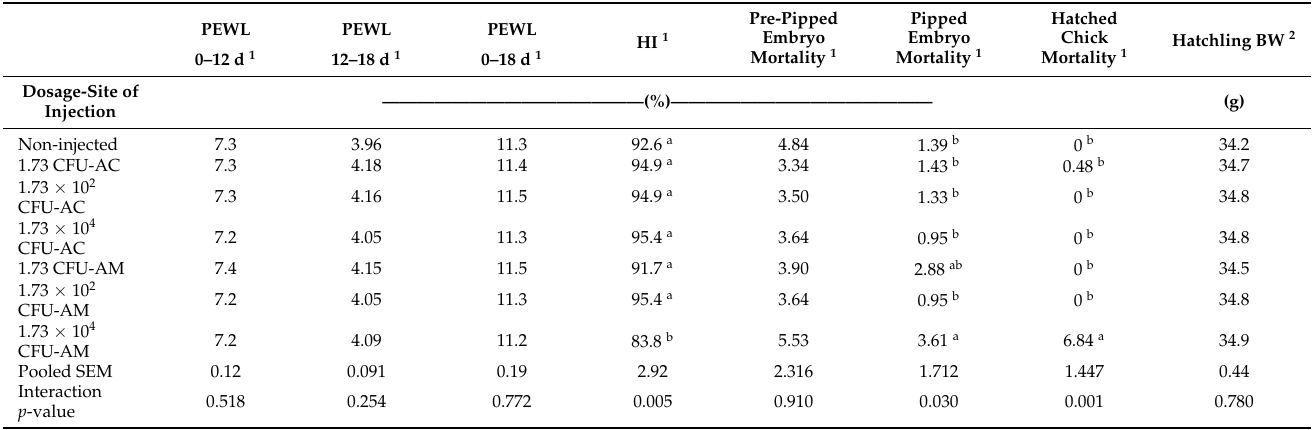
Table 4. Percentage egg weight loss ( PEWL ) between 0 and 12, 12 and 18, and 0 and 18 days ( d ) of incubation ( doi ) and hatchability of injected eggs containing viable embryos ( HI ), mean hatchling BW, pre-pipped and pipped embryonic mortality, and hatched chick mortality determined at pull time (22 doi) in non-injected eggs or eggs injected in the air cell ( AC) or amnion ( AM ) with